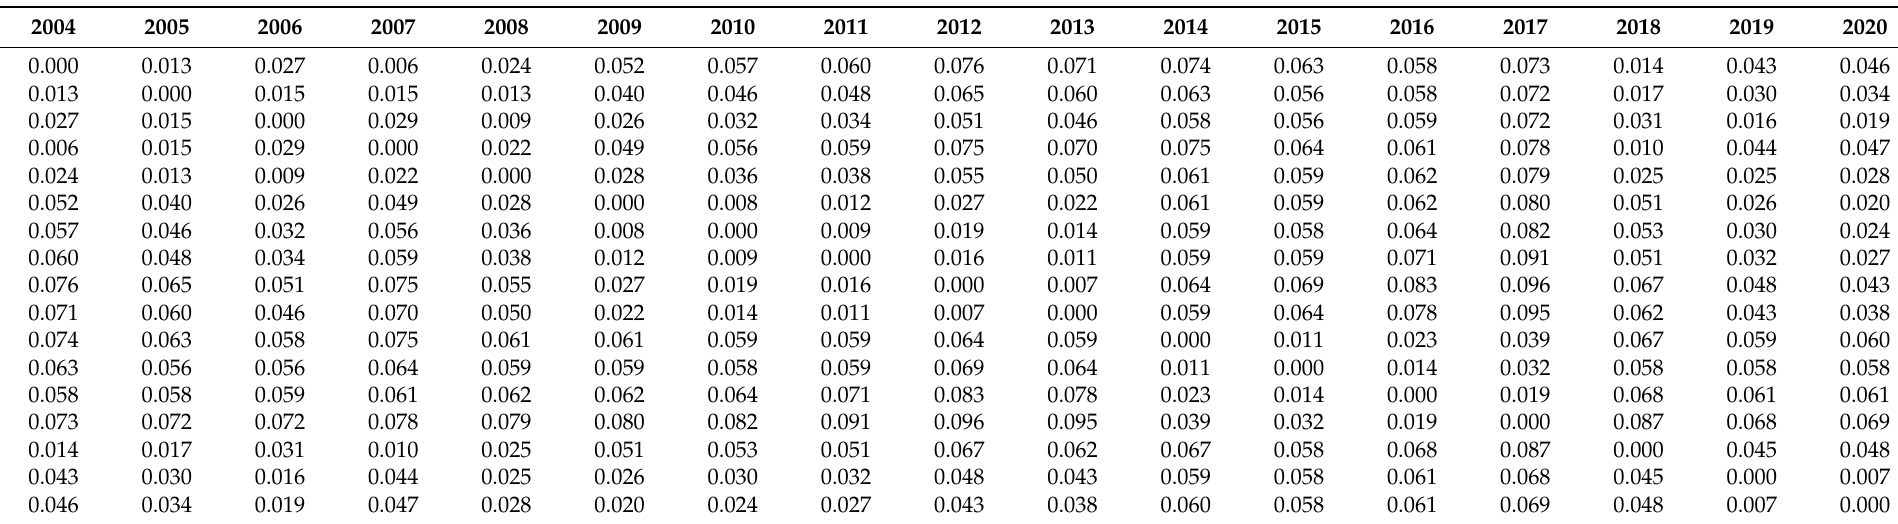
Table A4. Intensity of changes in the structure(NPS) of net fixed assets in mining enterprises in Poland in